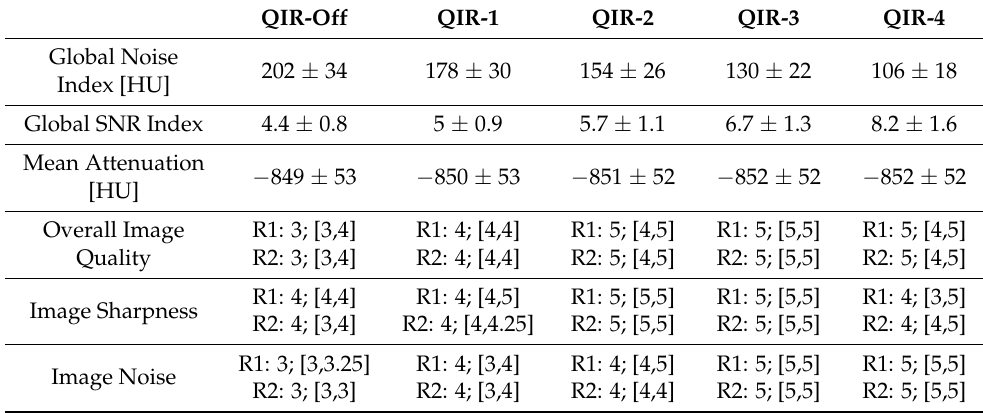
Quantitative data is presented as mean ± standard deviation. Qualitative data is presented as median; (interquar- tile range) for reader 1 (R1) and reader 2 (R2),